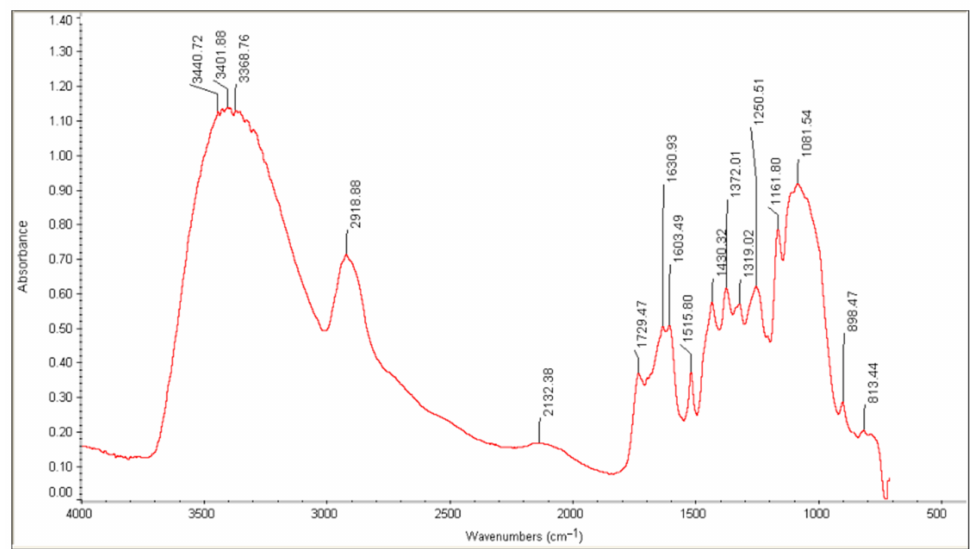
Figure 1. FT-IR spectrum of the activated charcoal.